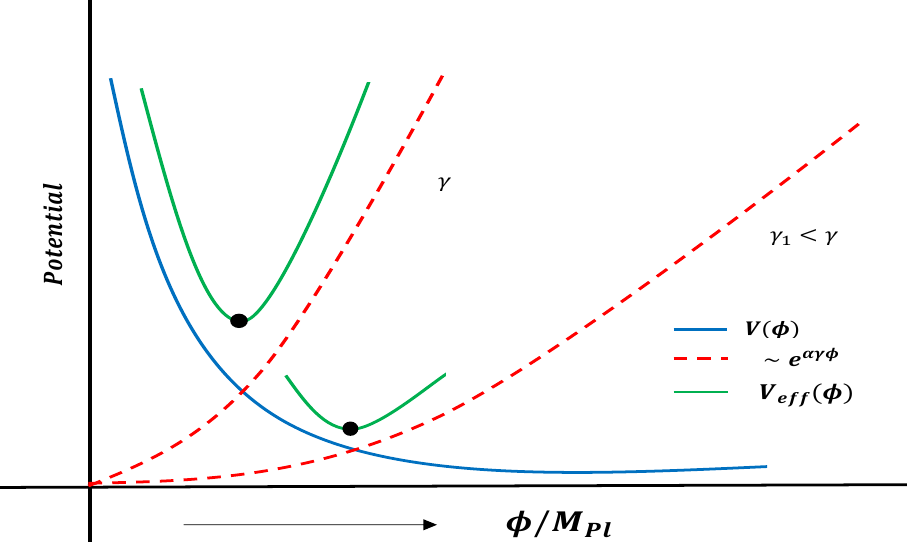
Figure 5. Schematic diagram showing the effective potential (green line); the original runaway type of potential is depicted by blue line. Coupling of field φ to massive neutrino matter manifests itself in the effective potential (108) through A ( φ ) ˆ ρ ν [ A ( φ ) = Exp ( αγφ / M Pl ) ], shown by dashed lines. The graph shows that for smaller values of γ , the minimum of effective potential hits larger values of the